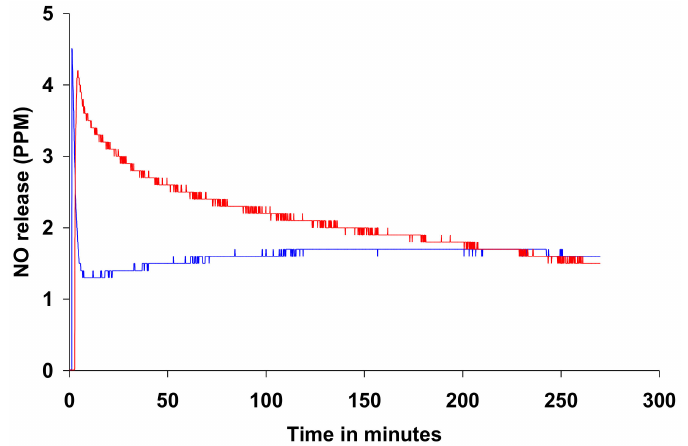
Figure 2. Rate of nitric oxide release from NAC-SNO-np, as monitored by a NO analyzer; NAC-SNO-np (red) or NAC-SNO (blue) was added to PBS, pH 7.4, at room